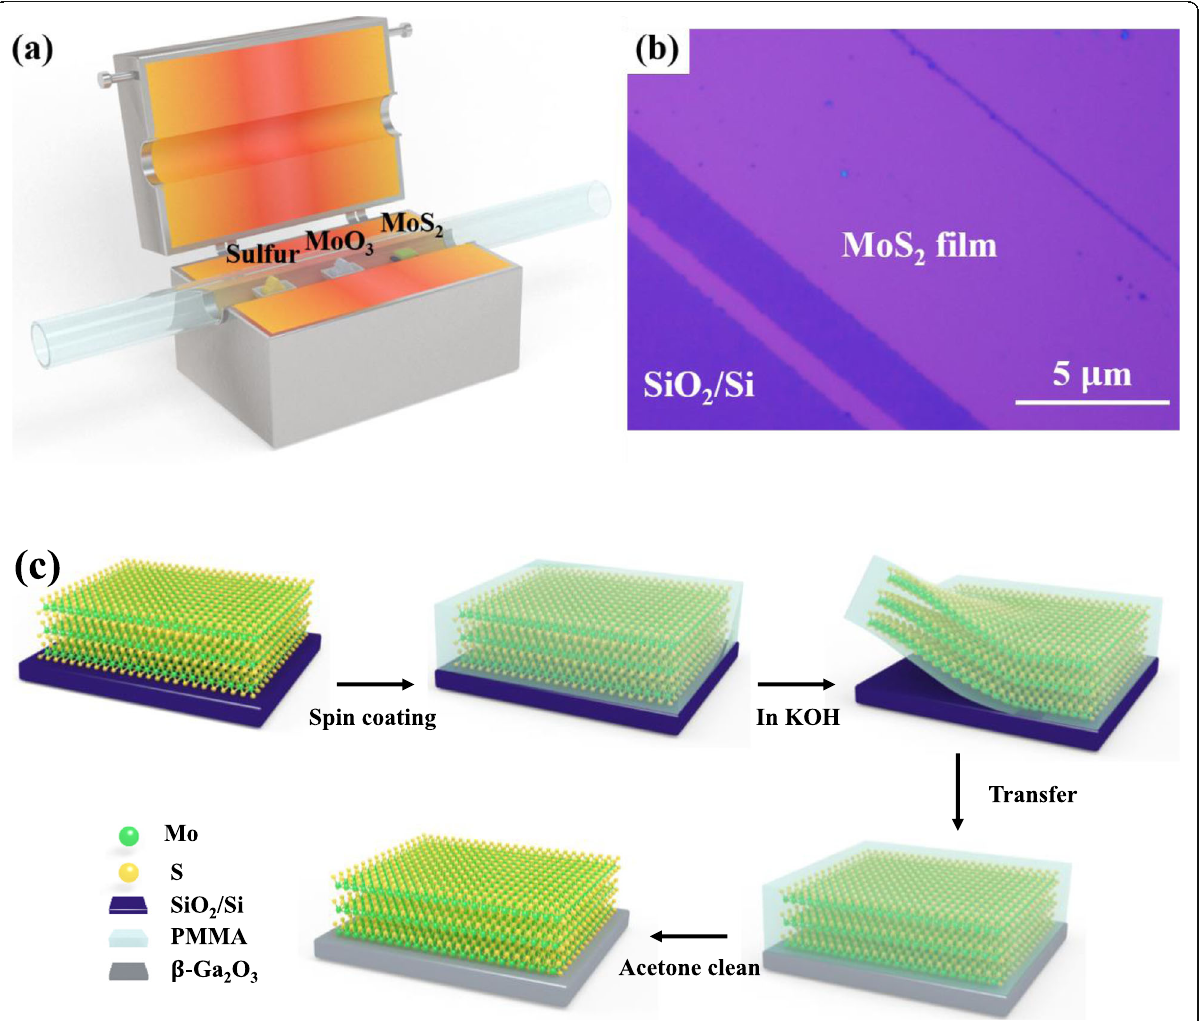
Fig. 1 a Schematic illustration of the experimental set-up for CVD-growth of MoS 2 . b Optical image for the as-grown few-layer MoS 2 film on SiO 2 /Si substrate. c Process flow of PMMA-assisted wet-transfer method for the MoS 2 / β -Ga 2 O 3 heterojunction